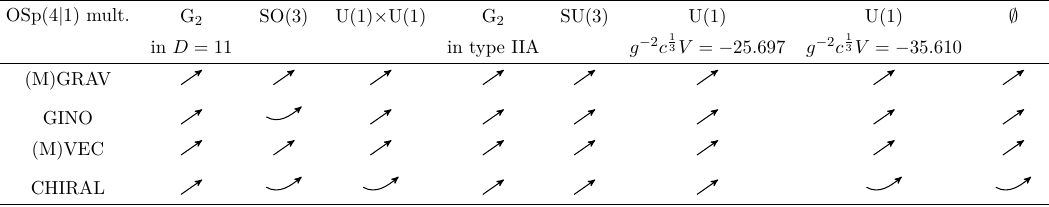
( n ) for all OSp (4 | 1) multiplets in 0